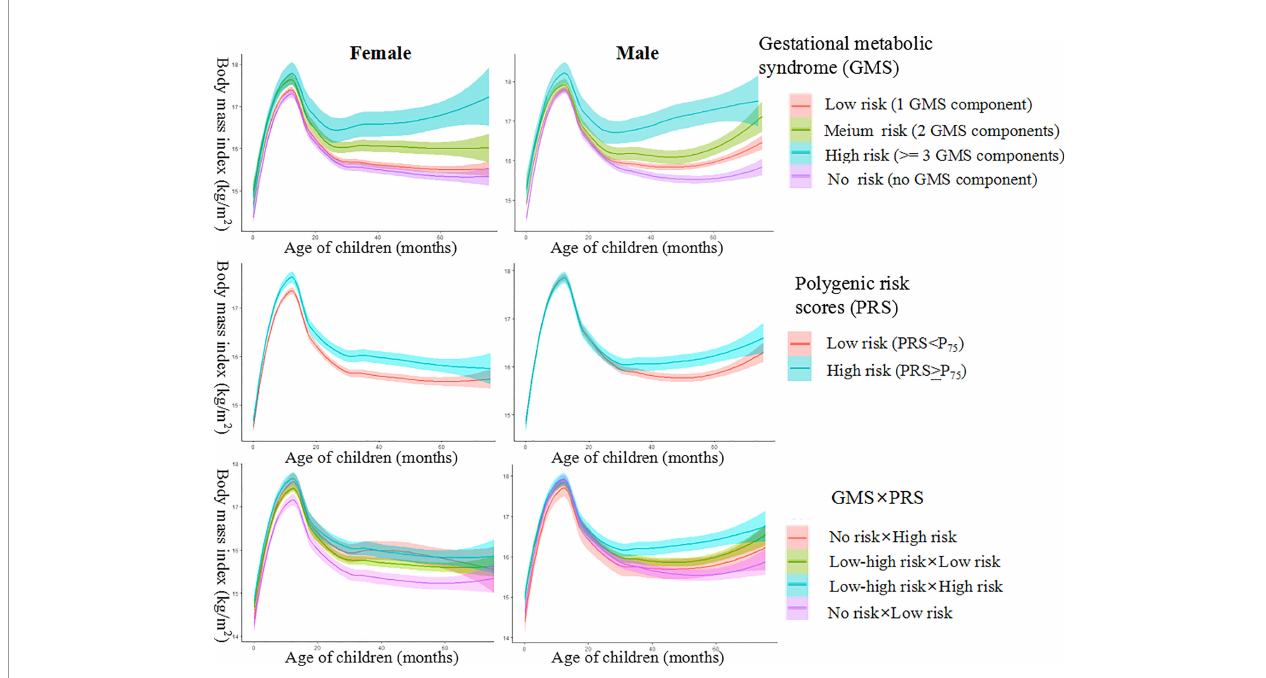
FIGURE 1 | Female and male body mass index (BMI) trajectory for groups of gestational metabolic syndrome risk, polygenic risk, and their